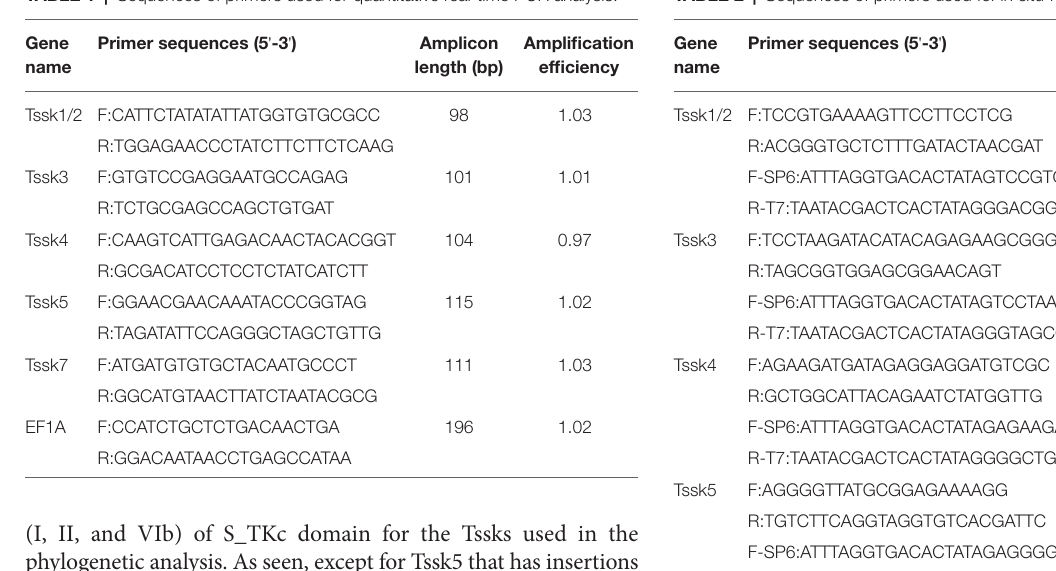
TABLE 2 | Sequences of primers used for in situ hybridization. TABLE 1 | Sequences of primers used for quantitative real-time PCR